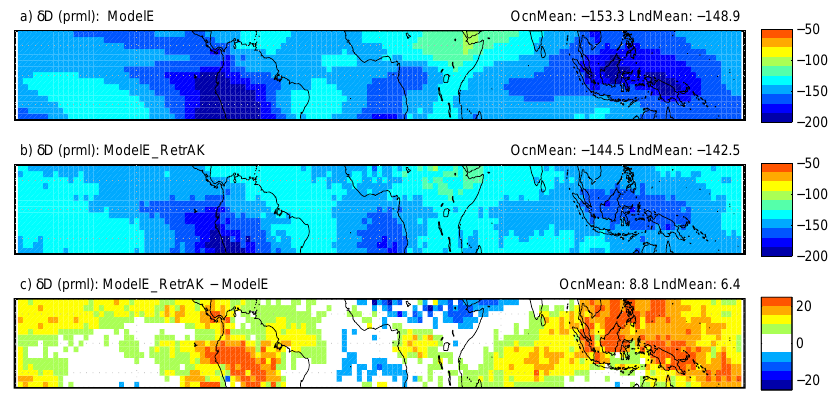
Fig. 14. (a) Raw ModelE vapor δ D between 825 and 511hPa during 2006 and 2009 for all months (b) ModelE vapor δ D after application of the retrieval based operator (c) difference between (b) and (a) . The vertical mean of δ D is weighted by specific humidity and pressure.